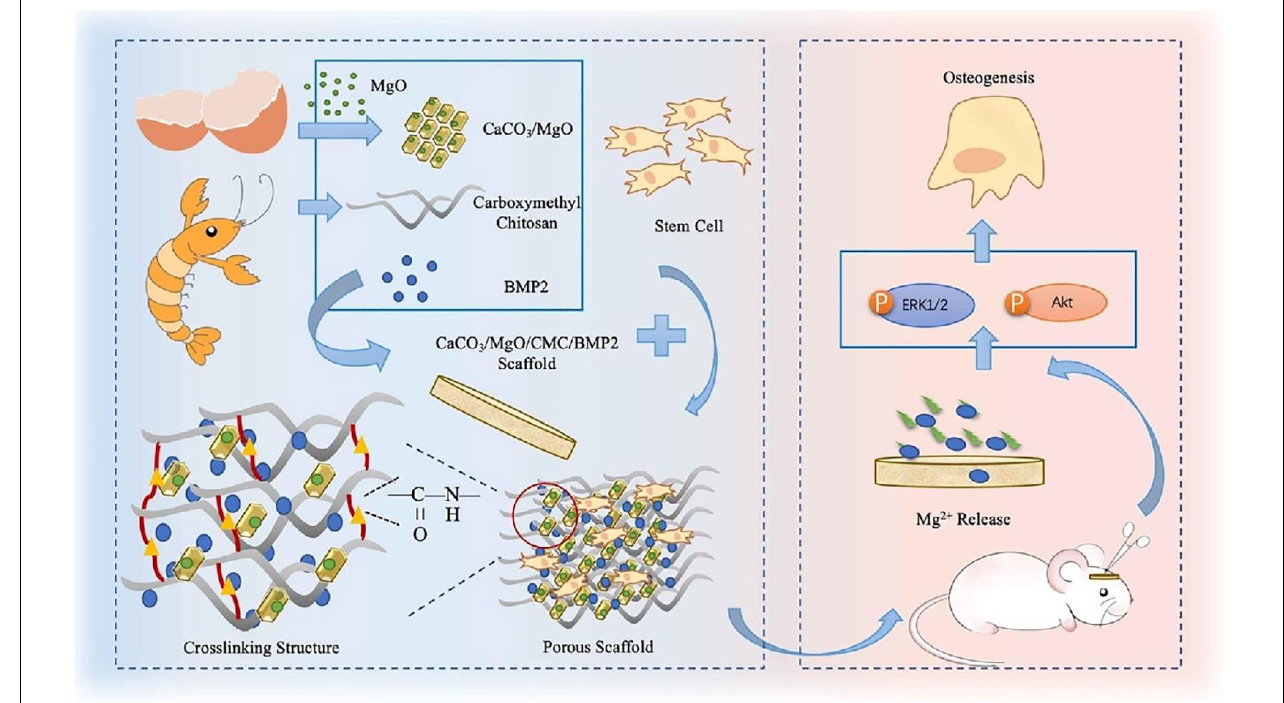
FIGURE 6 | Schematic preparation of CaCO 3 /MgO/CMC/BMP2 scaffolds and their applications in vivo . Reproduced from Huang et al. (2020) with permission from Copyright 2020